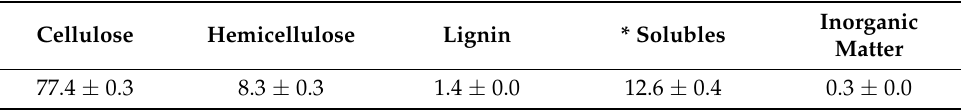
Table 1. The percentage biochemical composition of the untreated frost-retted hemp fibres used in this study [17].